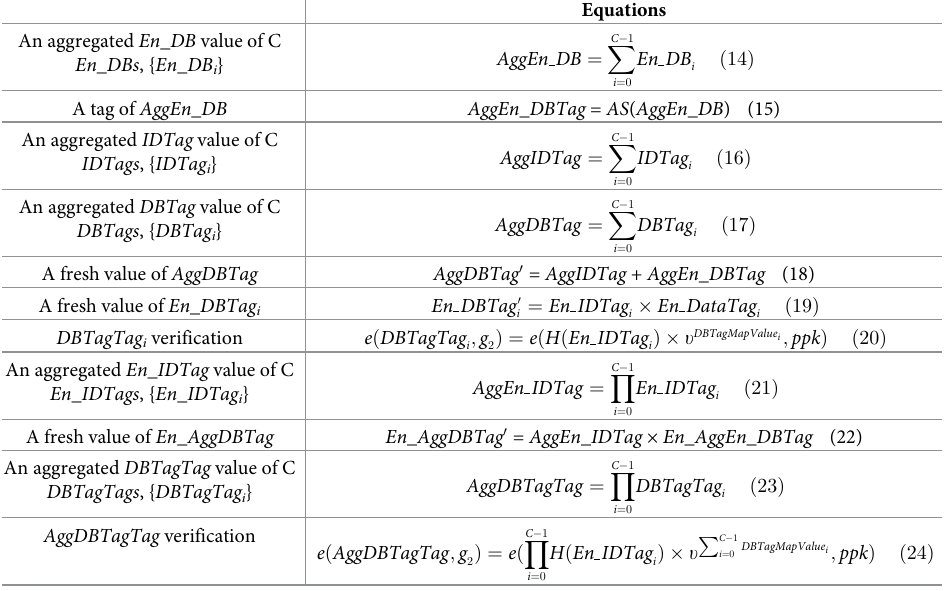
Table 5. Math equations for tag verifications (private and